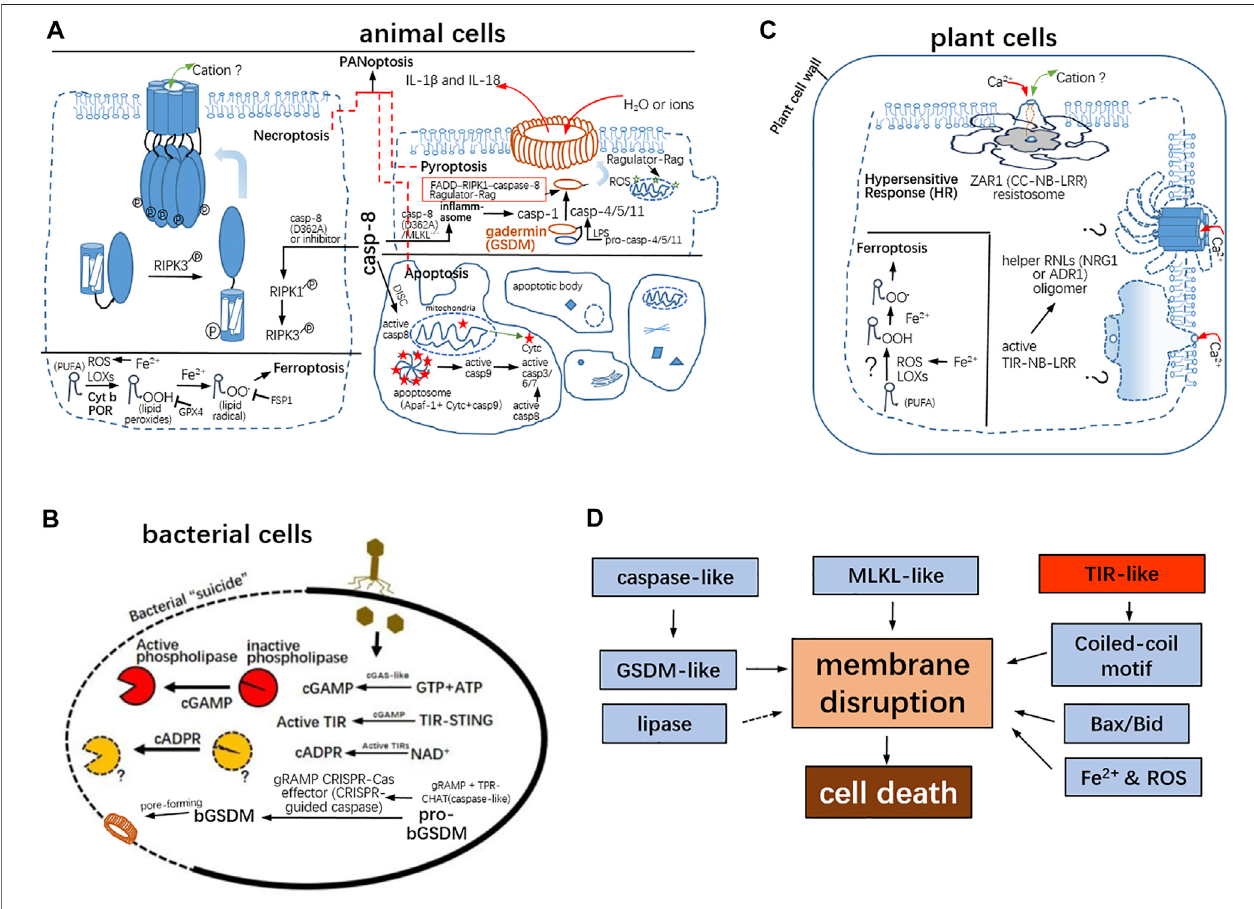
FIGURE2| CommonalityofvariousPCDsamongbacteria,animals,andplants. (A) NecroptosisismediatedbyRIPK3-phosphorylatedMLKL.Theoligomerization ofthe4-helicebundleintheN-terminalregionofMLKLshouldformacationchannelintheplasmamembraneandleadtodisruptionofmembraneintegrity.In fl ammatory caspases were activated by canonical and/or non-canonical in fl ammosomes. The active in fl ammatory caspases can cleave gasdermins. The resulting N-gasdermins inserttheplasmamembraneandformamembraneporewith18 – 21 nmininnerdiameter.ThegasderminporeprefersthereleaseofIL-1 β andIL-18.Apoptosisisa non-lyticcelldeath. Intheinstinct pathway, theinitiator caspase-9 isactivated bytheapoptosomeconsistingofapaf-1, Cytc,and caspase-9; caspase-8 isactivated by the death-inducing signaling complex (DISC) for extrinsic apoptosis. Caspase-8 is the molecular switch for apoptosis, for necroptosis, and pyroptosis. Ferroptosis is required for iron and is mediated by LOXs and ROS and POR and Cyt b. The lipid peroxides and lipid radicals are capable of being sequestered by GPX4 and FSP1, respectively. Upon infection, PANoptosis co-featured by pyroptosis, apoptosis, and necroptosis is present as well. (B) The bacterial gasdermins are conserved and commit cell death via pore-forming as well. cGAMP as the elicitor activates the phospholipase, which perturb membrane integrity and result in cell death. gRAMP, the giant repeat – associated mysterious protein from CRISPR-Cas type III effectors; TPR-CHAT, caspase HetF associated with the tetratricopeptide repeat. proteases (C) Resistance (R) protein-mediated HR and ferroptosis-like in the plant cell. The R protein ZAR1 (CC-NBS-LRR) with RKS1 and PBL2 UMP ligands form the pentameric complex. The funnel-like channel ( ∼ 0.5 nm in narrowest diameter) is a non-selective, Ca 2+ in fl ux, cation channel. Likewise, helper NLRs required for TLR (TIR-NB-LRR)- mediated HR constitute a Ca 2+ in fl ux, cation channel. But the de fi nitive 3D models of helper NLRs remain elusive; other CNL resistosomes may be cation channels, but their 3D structures are not be determined. And, ferroptosis-like cell death was also observed in plant cells. (D) In total, GSDM and MLKL domains directly target the plasmamembrane;theBcl-2familyisresponsibleformitochondrialmembranedamages;andTIR-likesenseandmonitorenergyde fi cittoproduceasecondmessenger for downstream signaling.